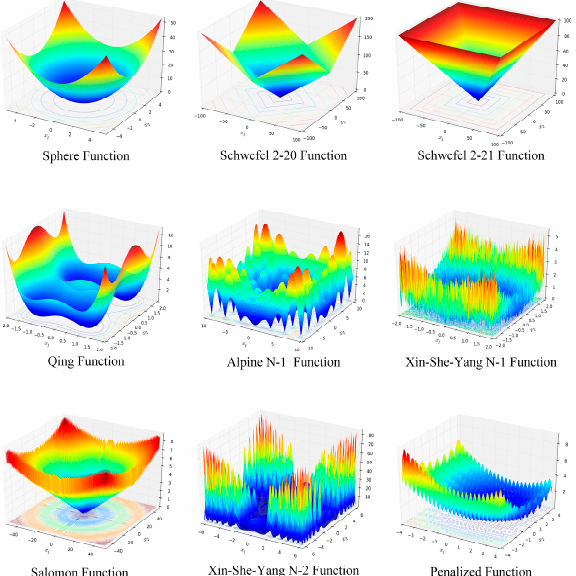
Figure 7. 3D design of the functions.